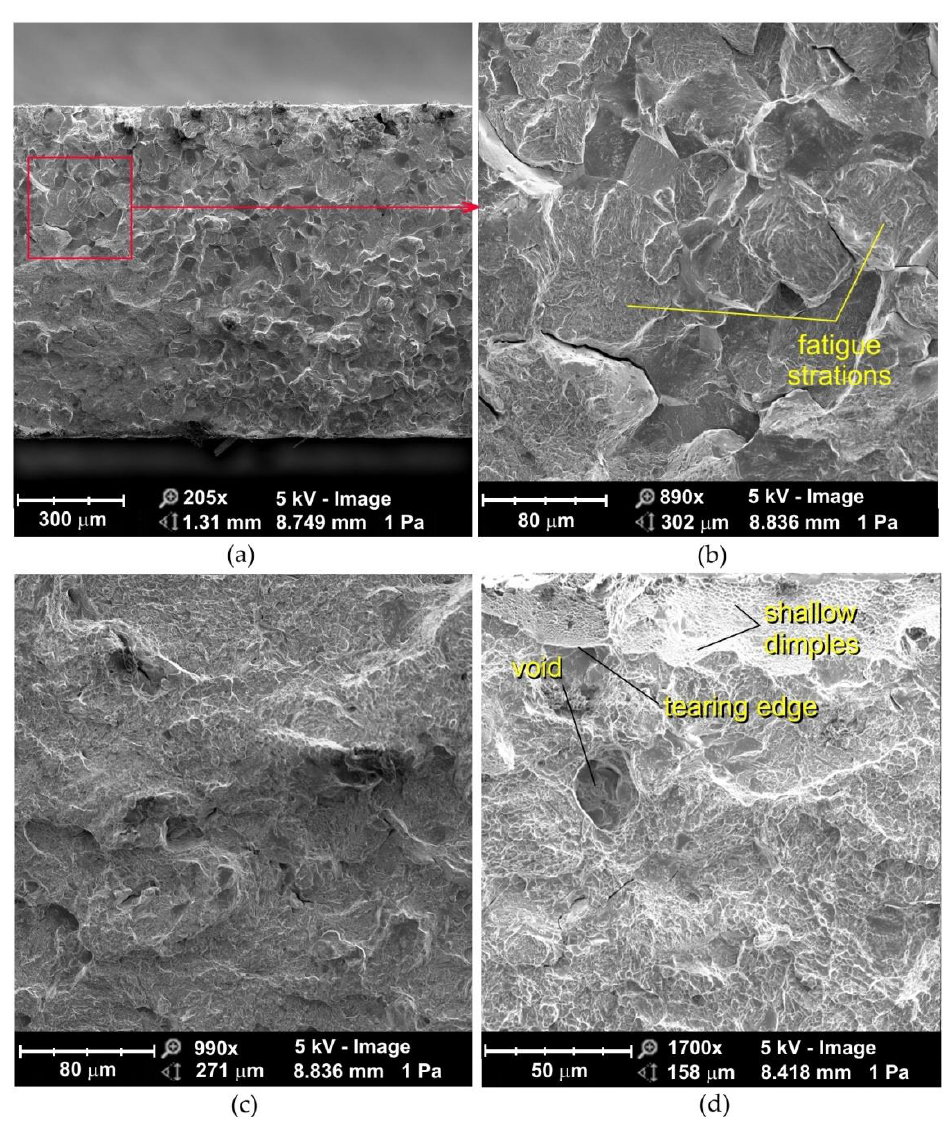
Figure 8. SEM micrographs of the fatigue fracture of non-sandblasted flash butt welded joints tested at a stress amplitude of 575 MPa: ( a ) cross-section of the fatigue fracture, ( b ) magnification of the subsurface area, and ( c , d ) view of the near-edge layer of the weld. The sandblasted samples in the vicinity of the fracture edge contain a network of dimples smaller in size than in the center of the flash butt weld (Figure 9a,b). Compressive stresses occur in the near-edge zone subjected to sandblasting. These stresses add to those resulting from plastic deformation and the resulting stress sign is reoriented in the subsurface layer. During further deformation of the weld material, local necks are formed between the micro-voids, and when breaking cause, the joining of the voids formed on the particles [38,40]. The processes associated with ductile fracture are usually related to particles of a different phase and the strength of the particle-matrix interface. This type of fracture, characterized by the presence of micro-voids, is due to the coalescence of microcracks that form the nuclei of microcracks in discontinuous areas and are associated with dislocations, second-phase particles, grain boundaries and inclusions [41]. As the deformation increases, the microcracks increase and eventually form a continuous